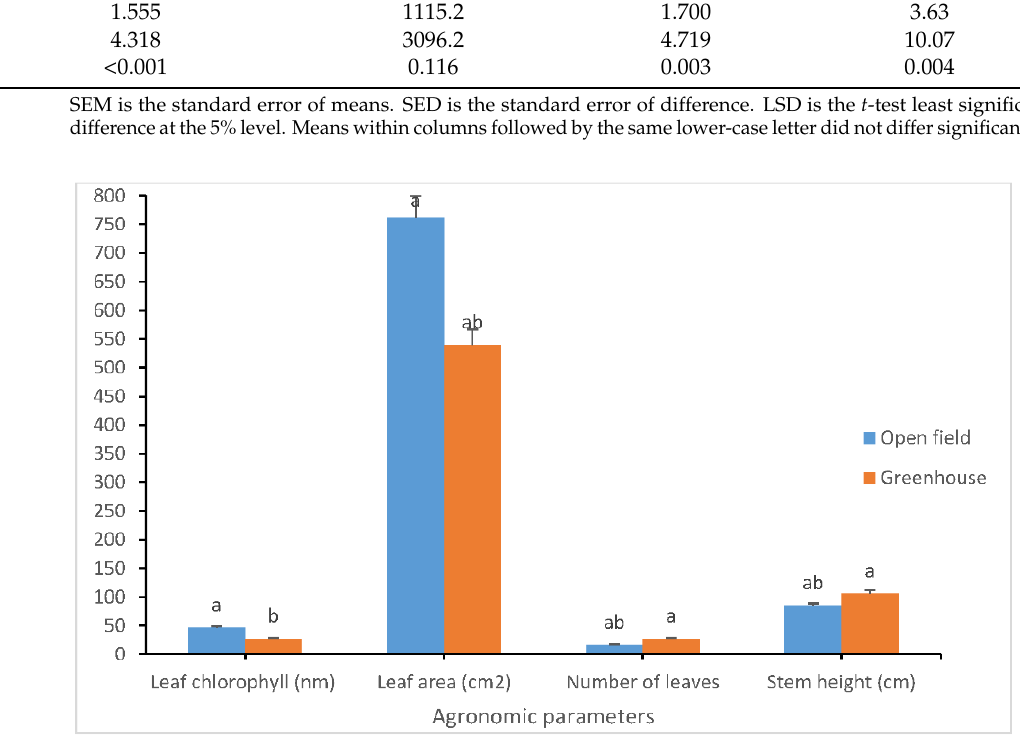
Table 2. Comparison of agronomic parameters A. Cruentus L. in the open field vs. greenhouse. Relative Chlorophyll Content